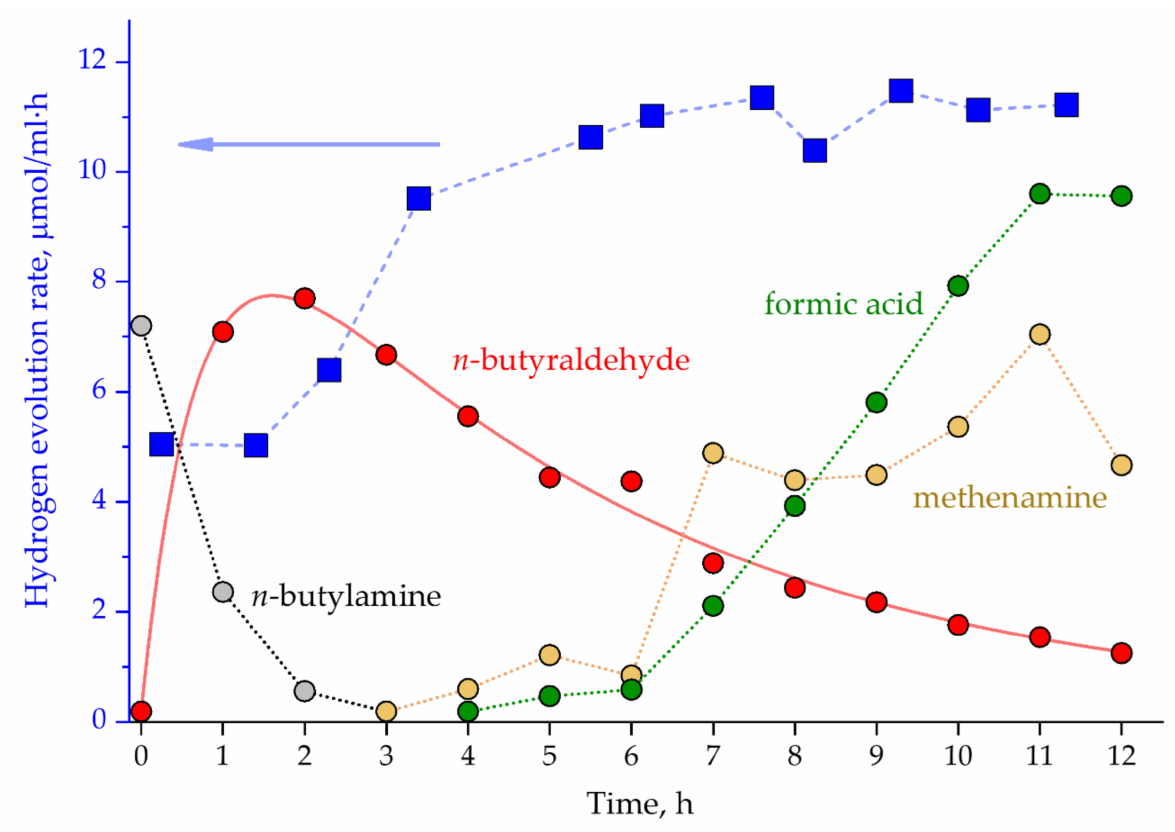
Figure 5. Dynamics of the main components detected via GC-MS in the reaction solution during photocatalytic hydrogen evolution over HLT 3 × BuNH 2 /Pt from 1 mol.% aqueous methanol for 12 h and the change in hydrogen evolution rate.